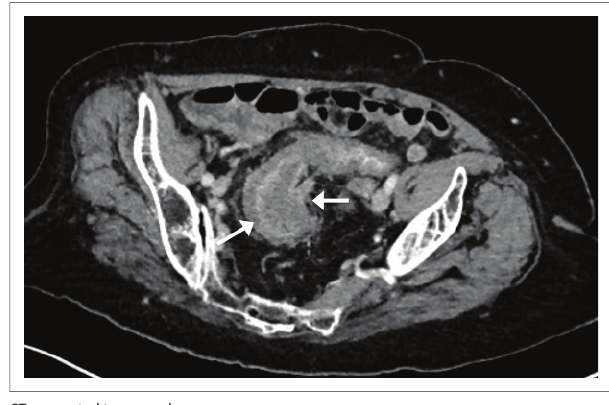
FIGURE 1: Coronal reconstruction of the portovenous phase of a CT abdomen of a 50-year-old male patient demonstrating lymphomatous circumferential thickening of terminal ileum and caecum (arrowed).